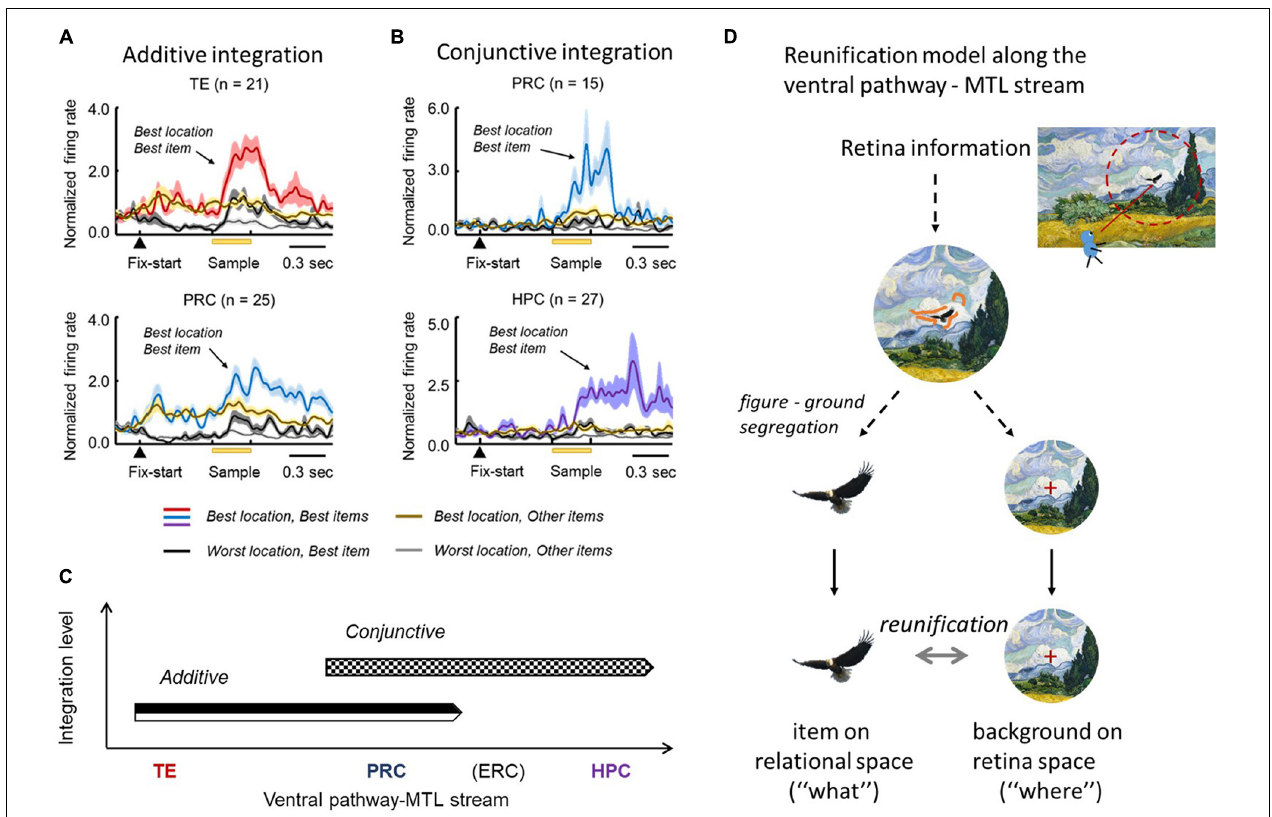
FIGURE 6 | Stepwise linkage of the location and item signals along the TE-PRC-HPC stream. (A) Population-averaged responses of neurons displaying additive integration in TE and the PRC in the F-V condition of the ILR task. These neurons started the location-selective responses after fixation, and the item-selective response was added after the sample presentation. (B) Population-averaged responses of neurons displaying conjunctive integration. Please note that the responses in the best location and best item demonstrate a robust increase, following the sample presentation in both the PRC and HPC. Adapted with permission from Chen and Naya (2020a). F-V, foveal-view; ILR, item-location-retention. (C) Additive and conjunctive types of integration process occurred sequentially along the ventral pathway-MTL stream. (D) Reunification model. Through the ventral pathway, the visual information from the retina first went through the figure-ground segregation process, where the item and location signals were segregated. After the two signals were separately processed, they were integrated again (i.e., “reunification”), at the single-unit level. The reunification process may be supported by the additive and conjunctive integrations along the ventral pathway—MTL